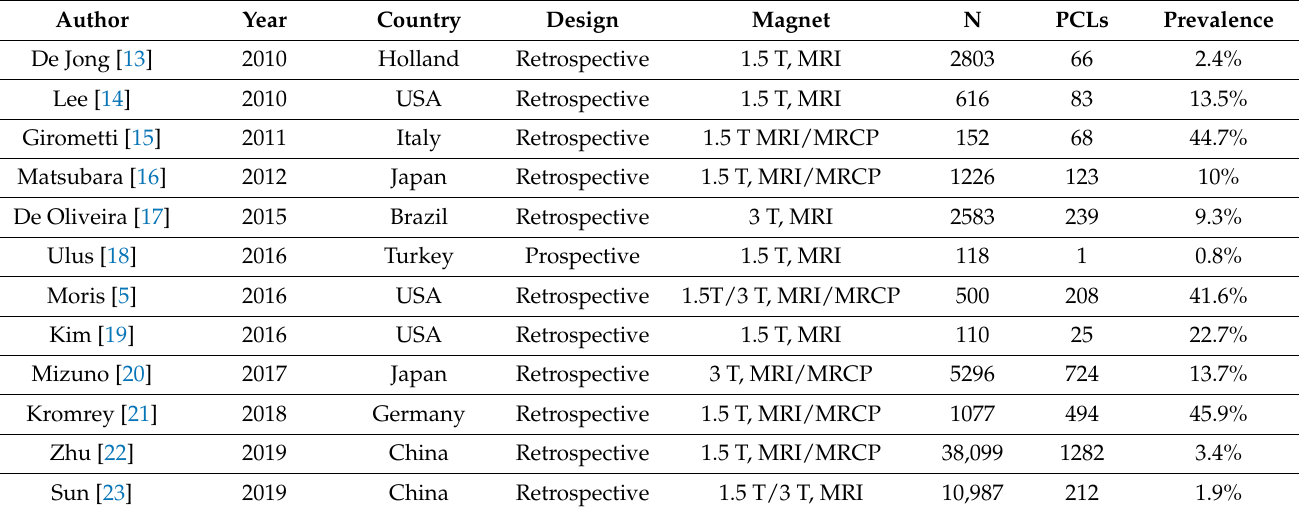
Table 1. Prevalence of incidentally detected PCLs in observational